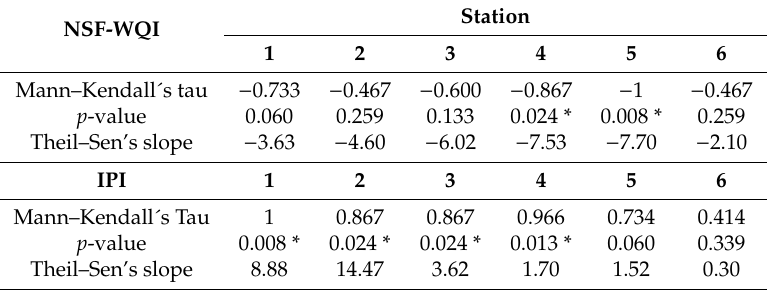
Table 8. Values of Mann–Kendall’s tau and Theil–Sen slope obtained for the National Sanitation Foundation-Water Quality Index (NSF-WQI) and Prati’s Implicit Index of Pollution (IPI) at measuring